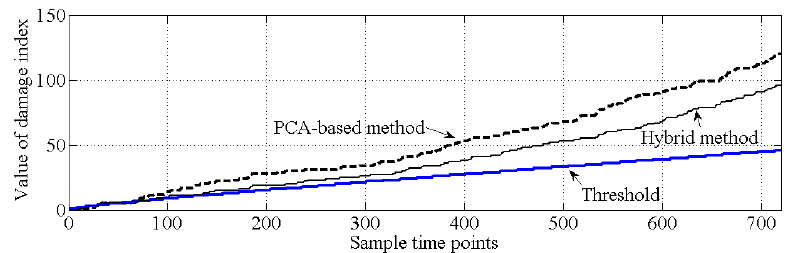
Figure 10. Comparison of the results of damage detection (case 1).